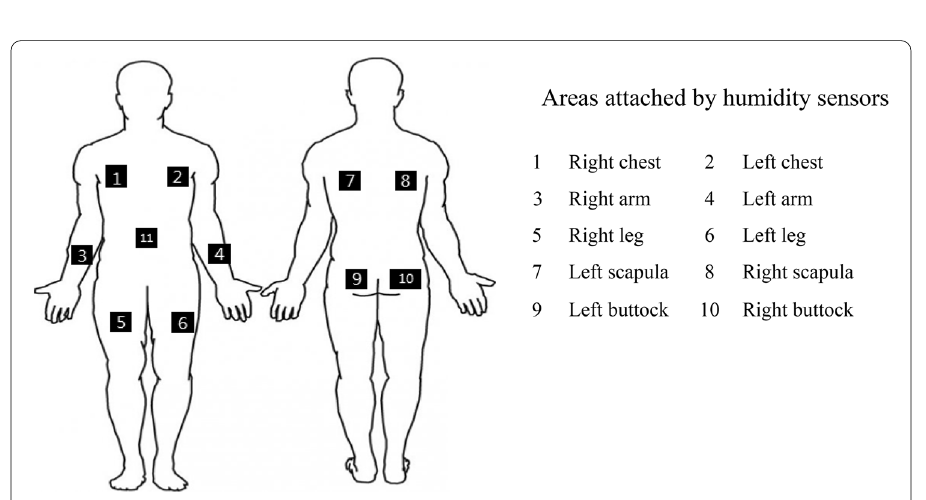
Fig. 2 Eleven body regions where humidity sensors were